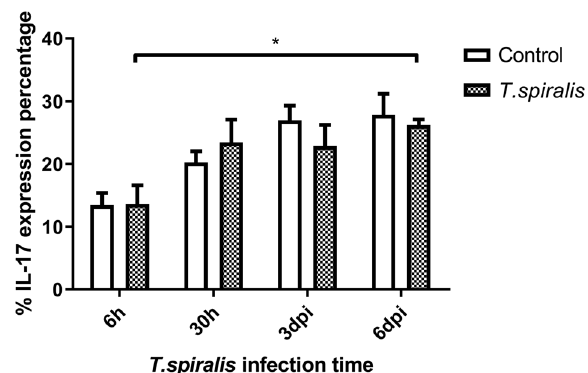
Figure 4. Percentage and expression levels of IFN- c of Th1 cells in mice infected with 250 muscle larvae of Trichinella spiralis compared to uninfected (control) mice from 6 h to 6 dpi. * p < 0.05 and ** p < 0.01 indicating a statistically signi fi cant difference.